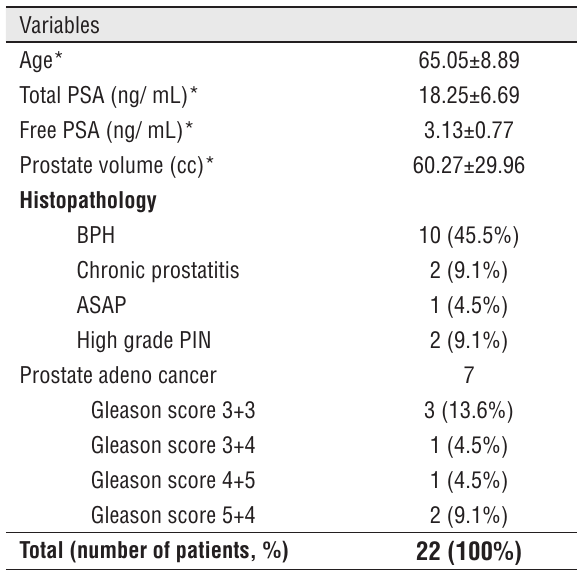
Table 1 - clinical data of men who underwent transrectal ultrasound guided prostate